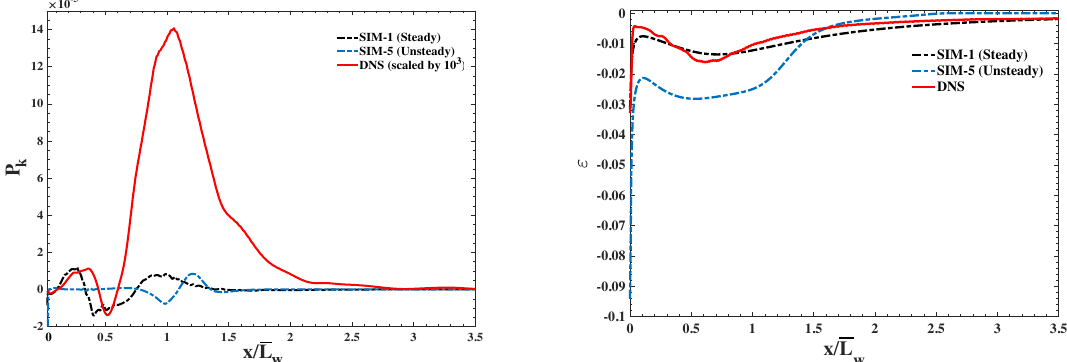
Figure 12. The turbulence kinetic energy production (left) and dissipation (right) along the wake centerline. x is normalized by the mean recirculation length and production results from DNS are scaled by 10 3